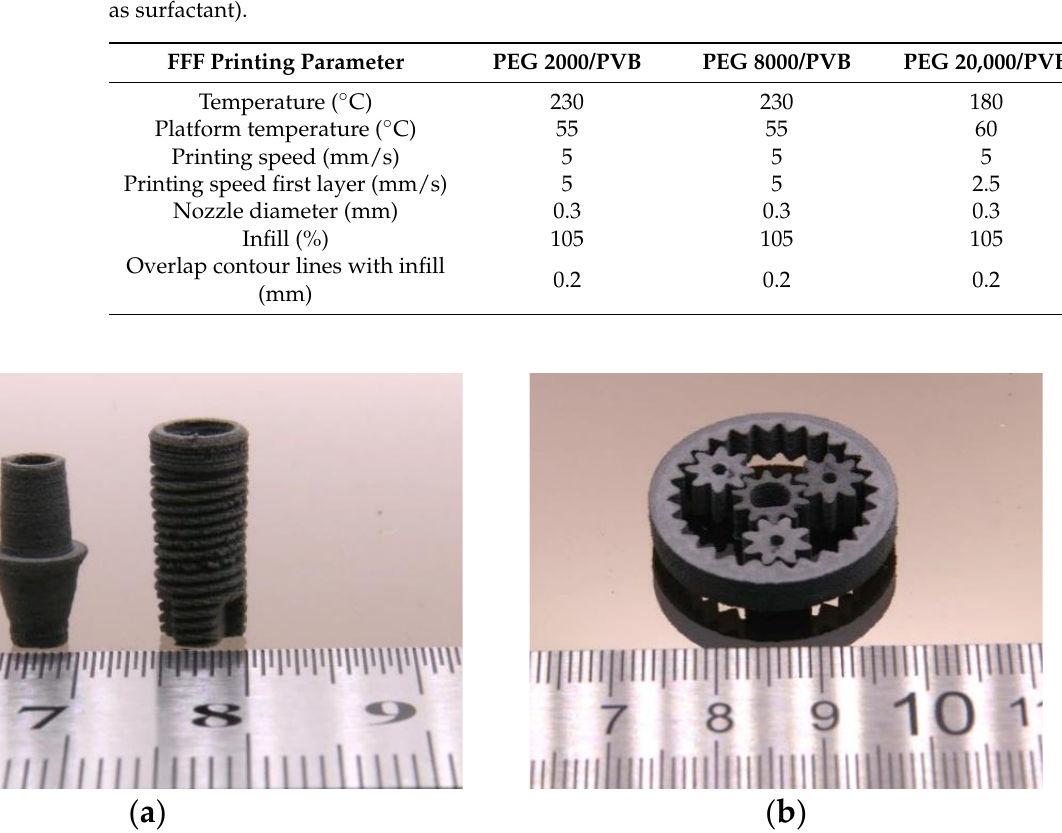
Table 3. FFF printing parameters for different PEG/PVB systems (solid load: 60 vol%, 5 wt% SA as surfactant).